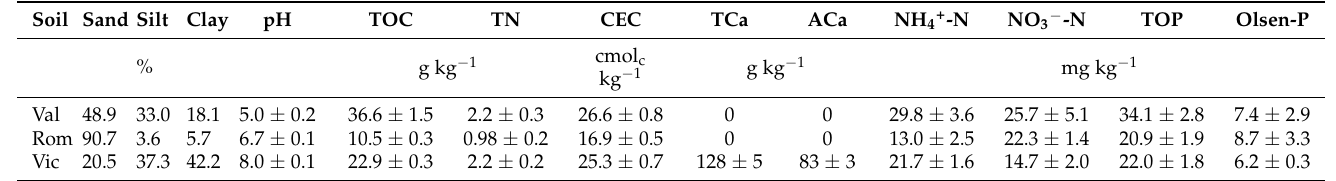
Table 1. Main physical and chemical properties of Vallombrosa (Val; acidic loamy forest), Romola (Rom; sandy arable) and Vicarello (Vic; clay calcareous forest) soils. Values are means ± SD (n =